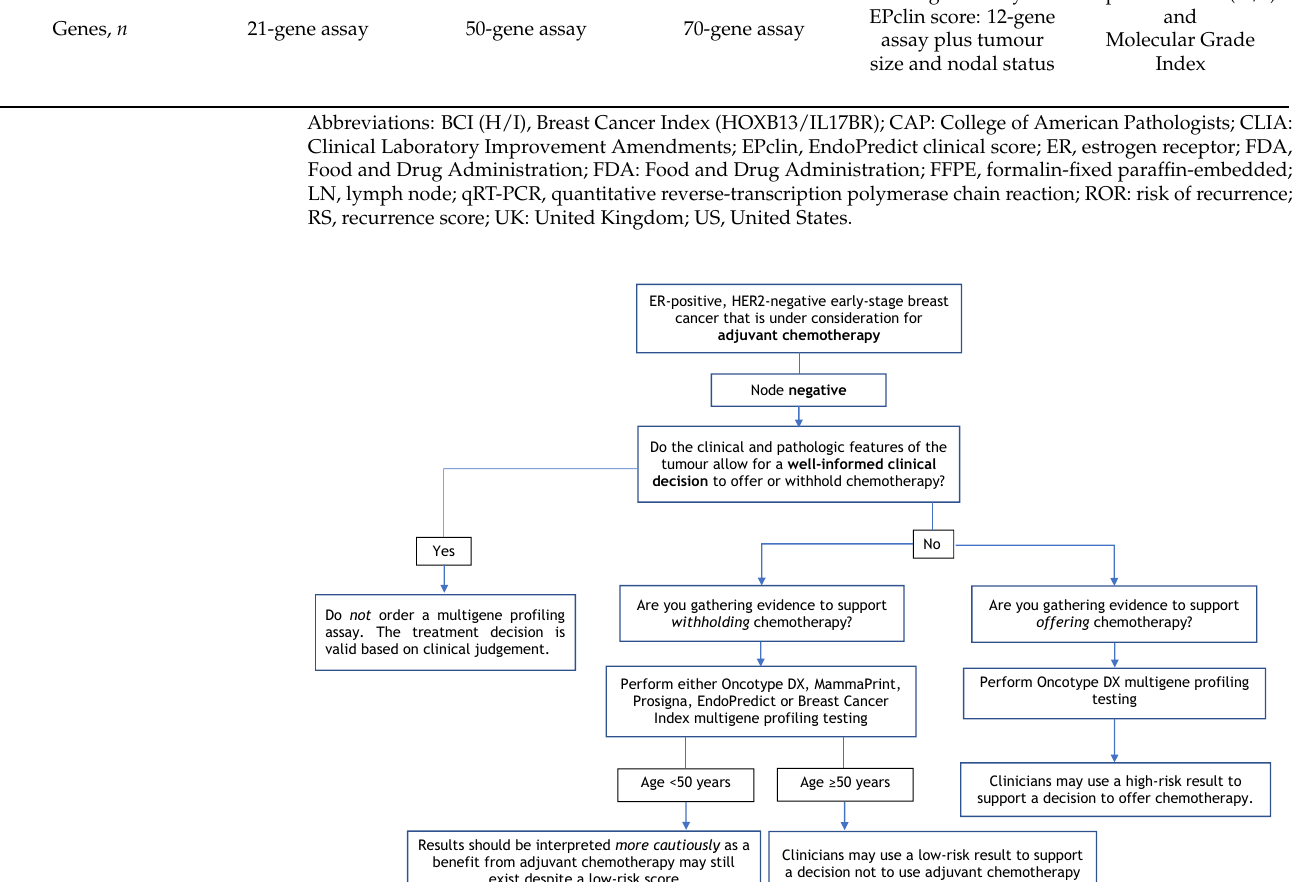
Figure 1. Multigene Profiling Assay Decision Tree for Adjuvant Chemotherapy in Node-Negative Patients.